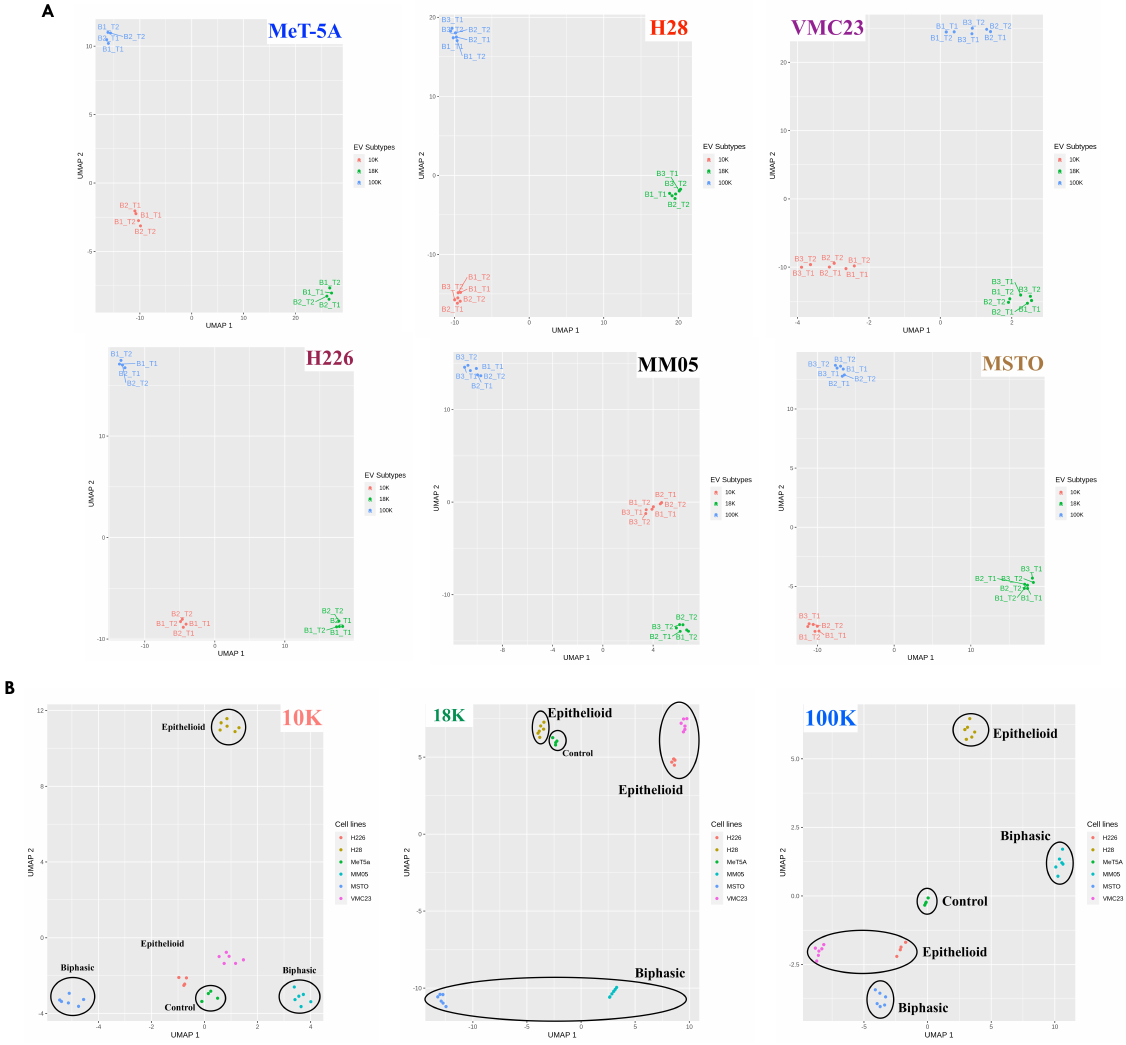
Figure 5. ( A ) UMAP plots showing a very clear separation between the EV subtypes across all cell lines. For each cell line, at least two biological replicates were included and within each biological replicate, two technical replicates were included. ( B ) UMAP plots according to the histological subtype of pleural mesothelioma. B: Biological replication; T: Technical